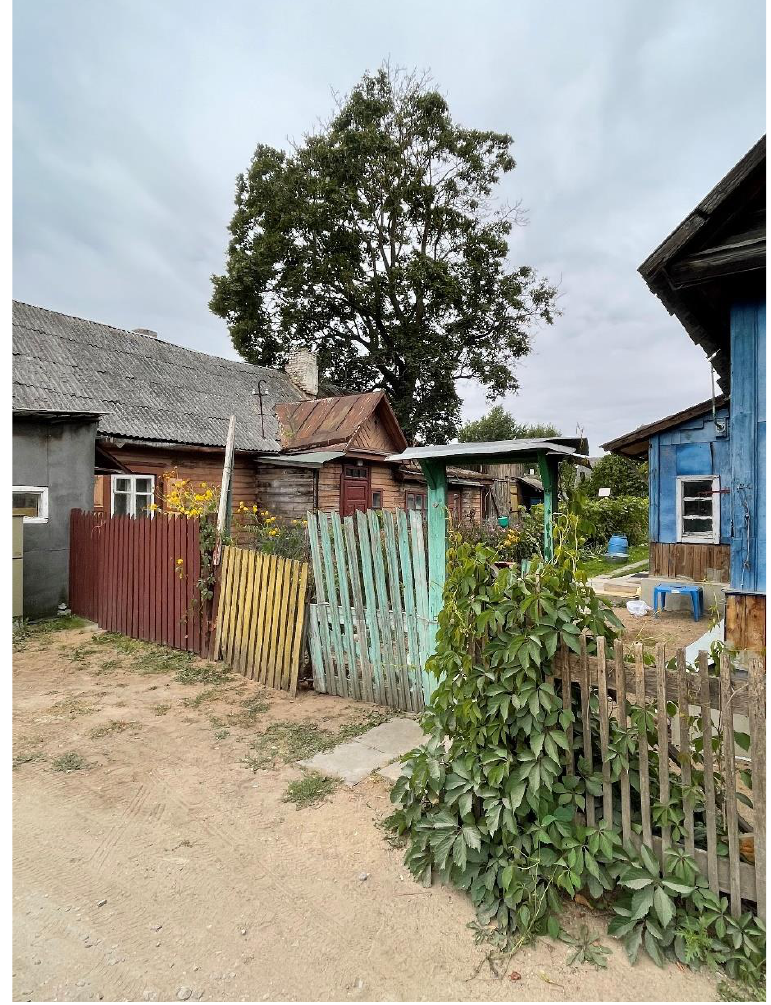
Figure 10. A g ate near a dwelling house in Šnipiškės. Photo by A. Gabrėnienė . Figure 10. A gate near a dwelling house in Šnipišk˙es. Photo by A. Gabr˙enien˙e. Figure 10. A gate near a dwelling house in Šnipišk˙es. Photo by A.